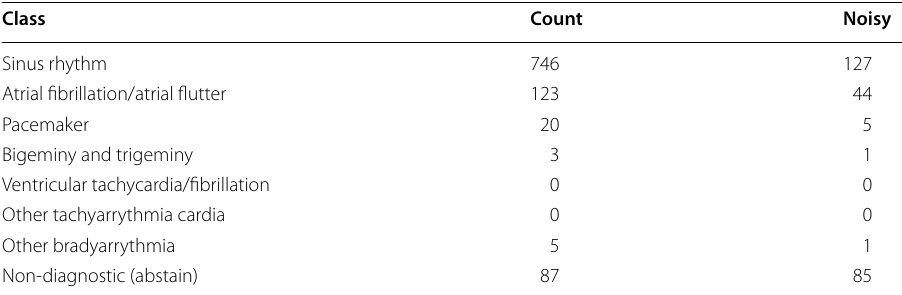
number of samples identified as